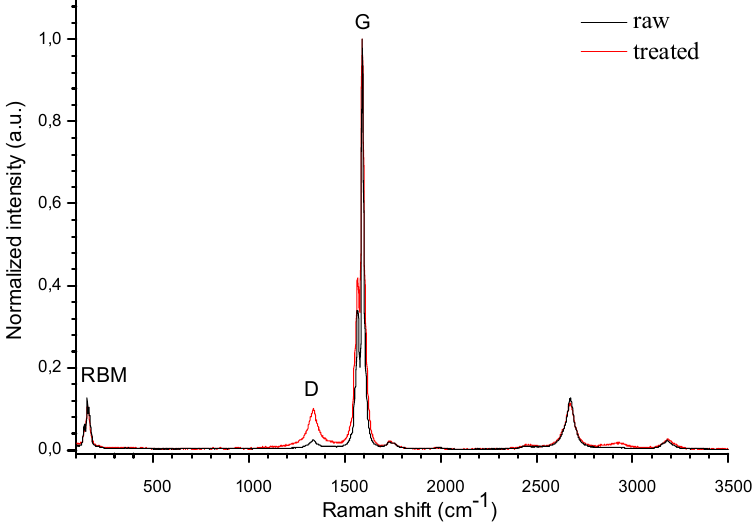
Figure 4. The Raman spectra of the raw nanotubes and the nanotubes treated with